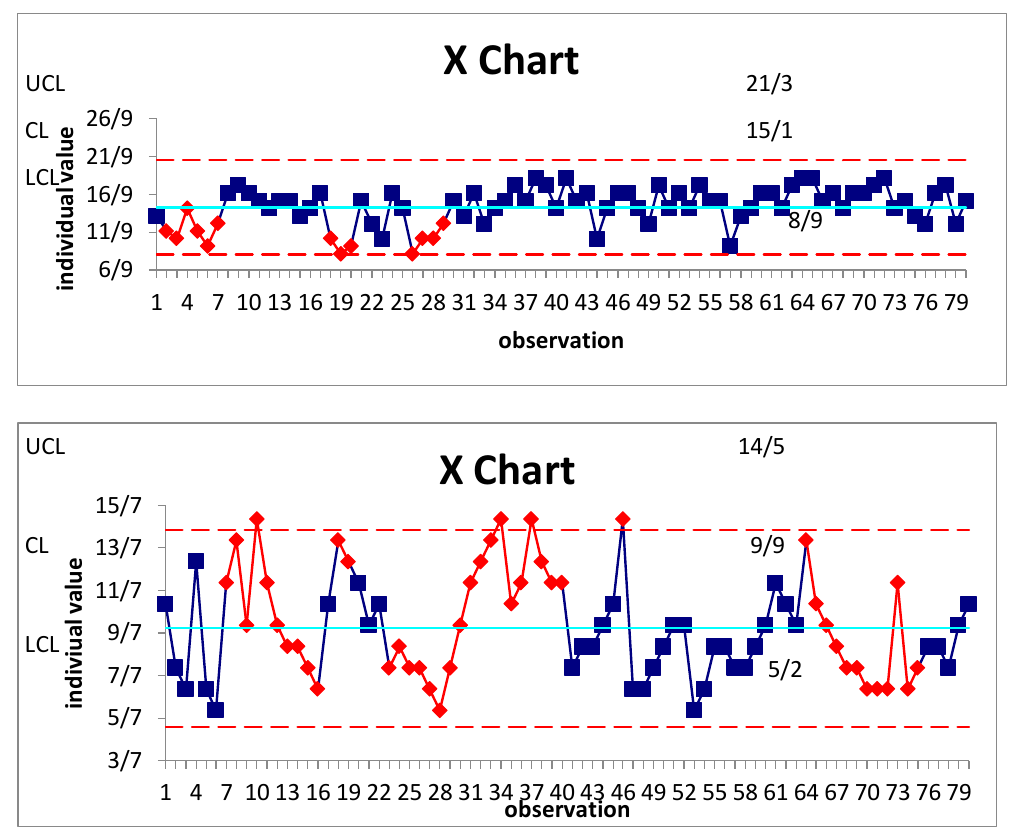
Fig. 23. X-Chart for the receiving data before improvement and after